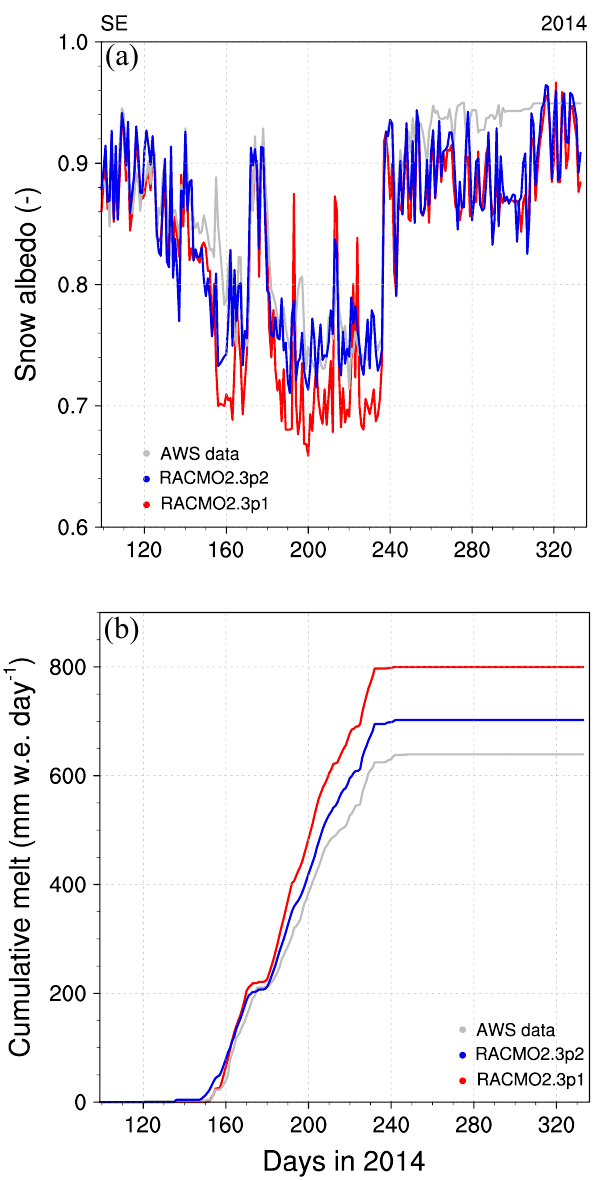
Figure 10. Time series of (a) daily snow albedo, and (b) cumula- tive surface melt (mmw.e.day − 1 ) modelled by RACMO2.3p2 (blue lines), RACMO2.3p1 (red lines) and measured (grey lines) at the south-eastern AWS (66 ◦ N; 33 ◦ W; 1563ma.s.l.) during summer